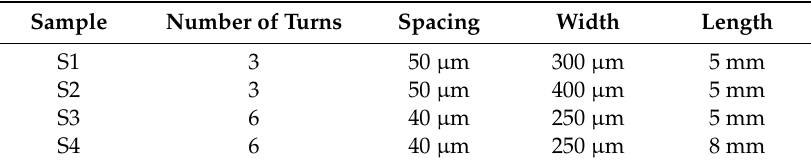
Table 1. Selected parameters of Co 75 Fe 10 Ni 2 Si 8 B 5